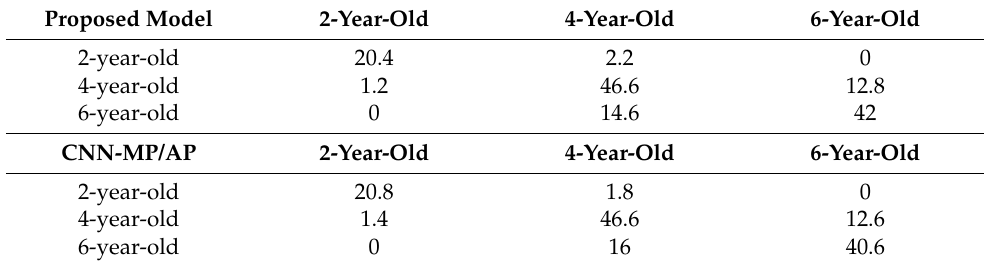
Table 7. Confusion matrix. Each value is an average in